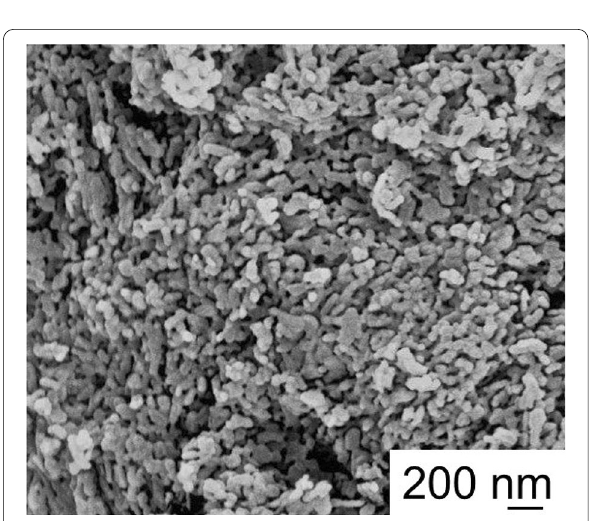
Fig. 6 SEM micrograph of the calcined powder